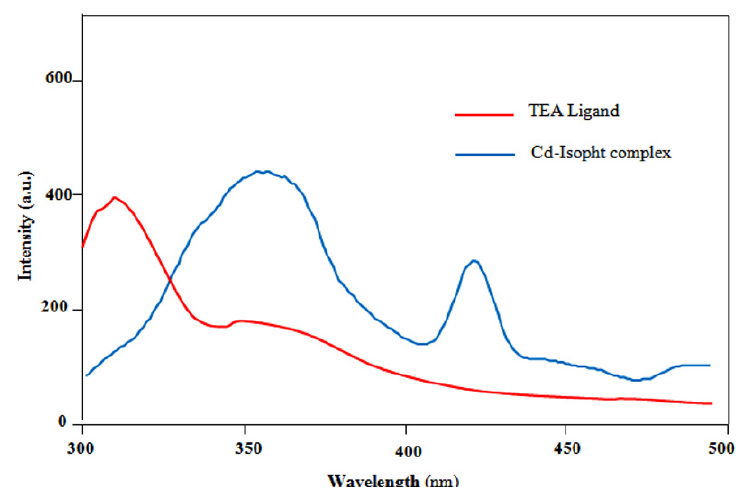
Figure 7. Fluorescence spectrum of [Cd(IsoPht)(TEA)H 2 O]·3H 2 O complex and TEA ligand in the solid-state (λ ex = 270 nm) Table 4. Diameter of zones of inhibition (mm) of [Cd(IsoPht)(TEA)H 2 O]·3H 2 O complex